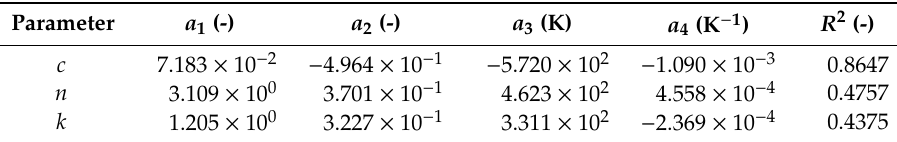
Table 6. Material constants for the description of c , n, and k